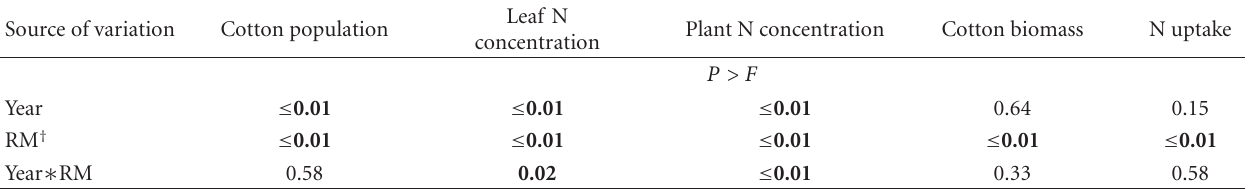
Table 1: Analysis of variance for cotton population, leaf N concentration, plant N concentration, cotton biomass, and N uptake at first square as a ff ected by year and rye residue management. P values within a row in bold are significant at α ≤ 0 .